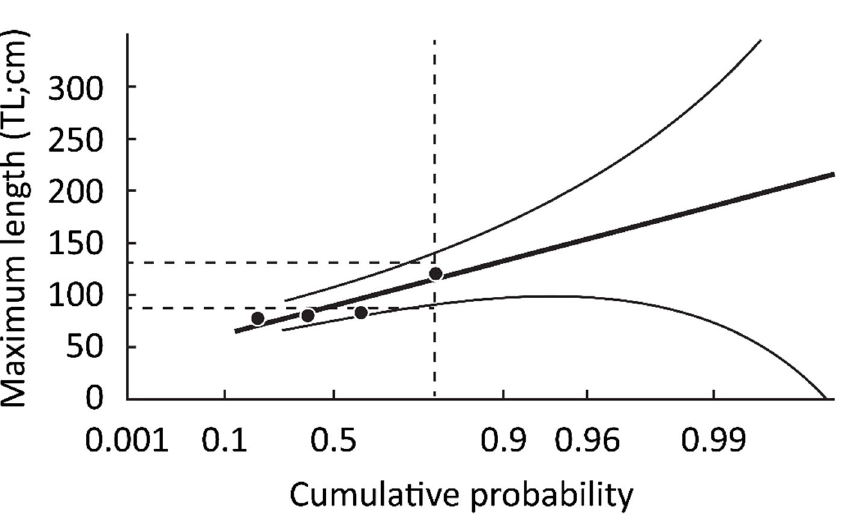
Figure 2. ‘Extreme value plot’ based on the first 4 maximum length estimates in Table 1, as outputted by FiSAT software [25]. The most probable potential maximum length was 110 cm, with a 95% confidence interval ranging from 87.3 to 132 cm total length.